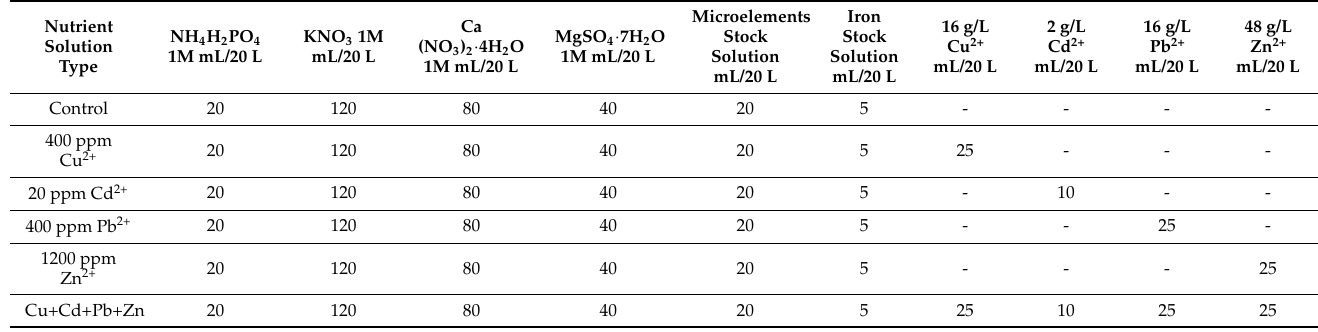
Table 6. Quantities required for the preparation of 20 L of Hoagland nutrient